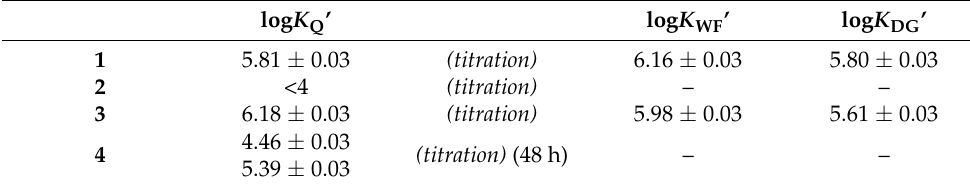
Table 5. Conditional binding constants of the compounds at binding sites I and II of HSA deter- mined by spectrofluorometric Trp-214 quenching (log K Q ’) and site marker (WF or DG) displace- ment (log K WF ’ and log K DG ’) measurements. {pH = 7.40 PBS’ buffer; T = 25 °C}.